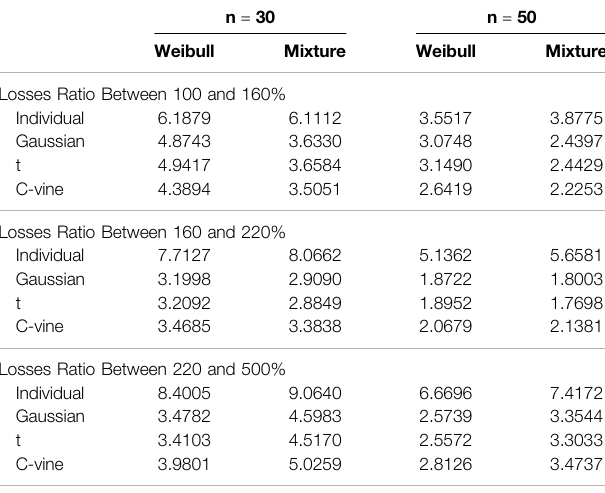
TABLE 15 | The average Mean Squared Error of aggregate losses at different layers for states in Group